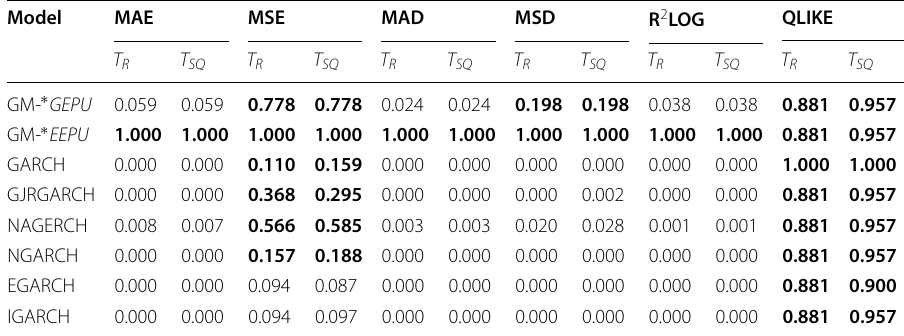
Table 6 MCS test results of the model (using the logarithmic growth rate of EPU)